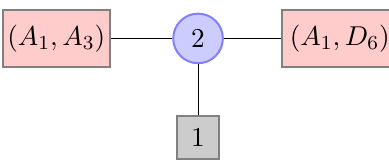
Figure 2 . A quiver diagram describing a weak coupling limit of the ( A 2 , A 5 )